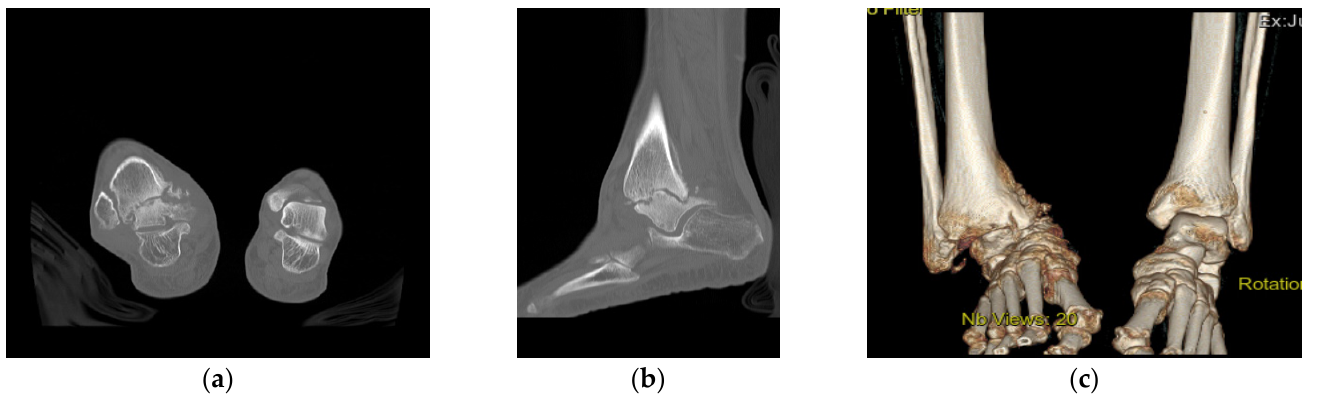
Figure 3. Preoperative coronal CT image showing a severe defect in the distal tibia and nearly undetectable medial malleolus ( a ). Sagittal CT scan showing a destroyed tibiotalar joint and anterior tibia migration to the talus ( b ). The 3D reconstructed CT image shows severe varus deformity of the right ankle joint ( c ).